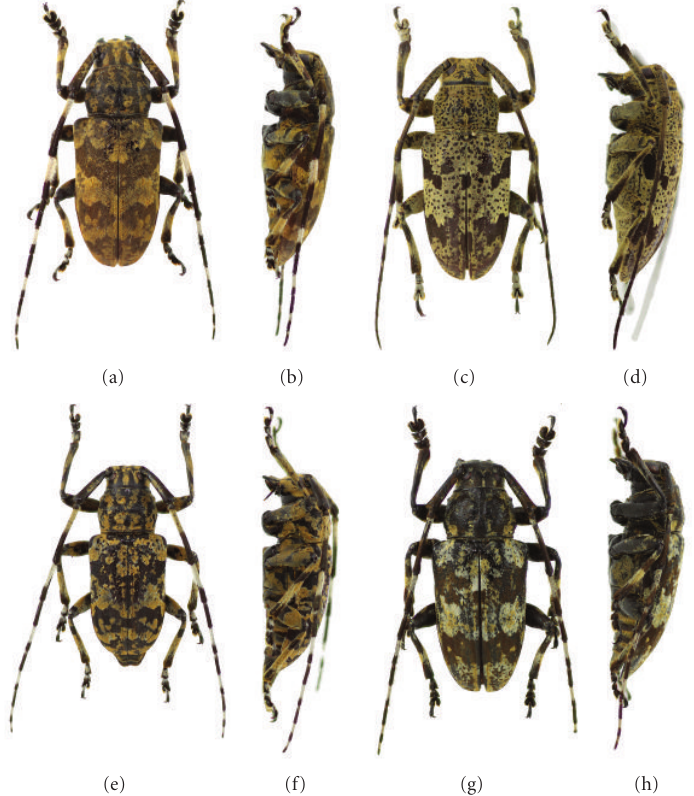
Figure 4: Male habitus of Agelasta ( Dissosira ) spp. (a, b) A. ( D. ) yonaguni ; (c, d) A. ( D. ) nigrostictica ; (e, f) A. ( D. ) praelongipes ; (g, h) A. ( D. ) kumei ; (a, c, e, g) dorsal view; (b, d, f, h). lateral